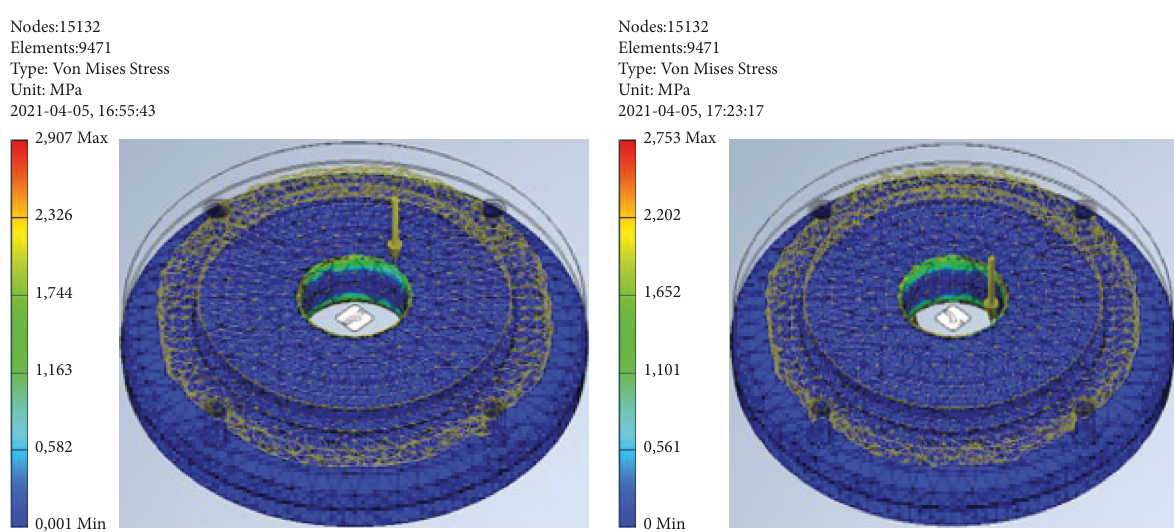
Figure 9: Topology optimized compliant C-clamp plate (mild steel and ABS plastics).